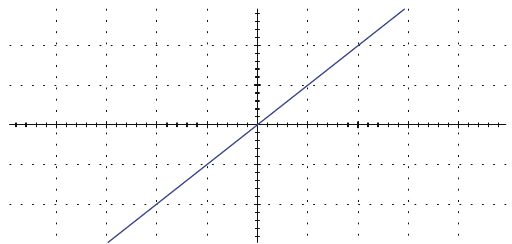
− x waveform at the time of 1 2